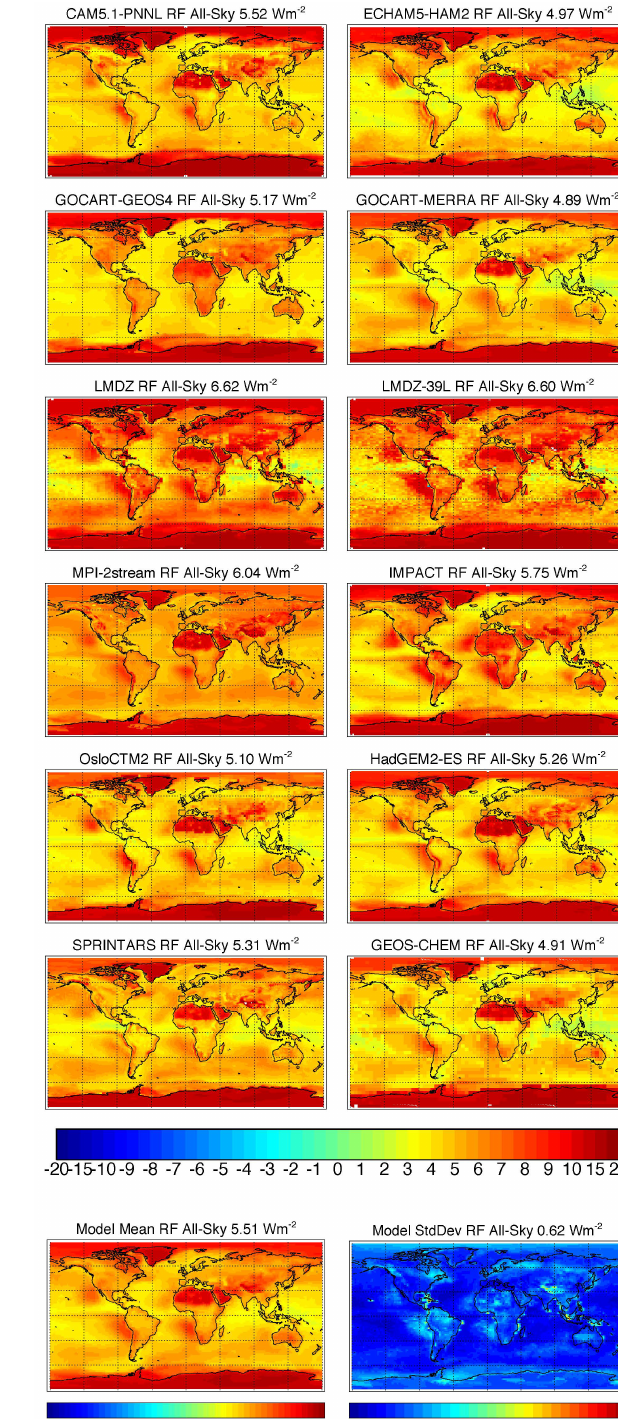
Fig. 12. Annual mean short-wave clear-sky top-of-atmosphere ra- diative forcing (RF) with AOD=0.2 distributed over the lowest two kilometers between experiments with SSA=0.8 and SSA=1.0 with holding ANG=1.0 constant (FIX3-FIX2).